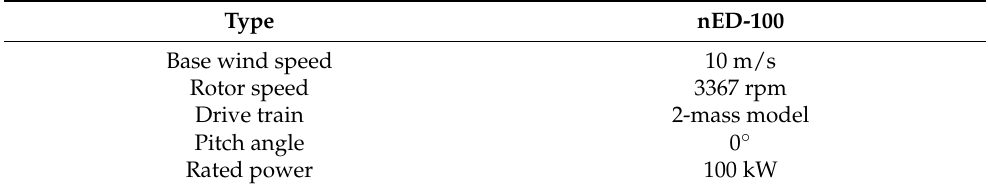
Table A1. Parameters of VS-WECS.